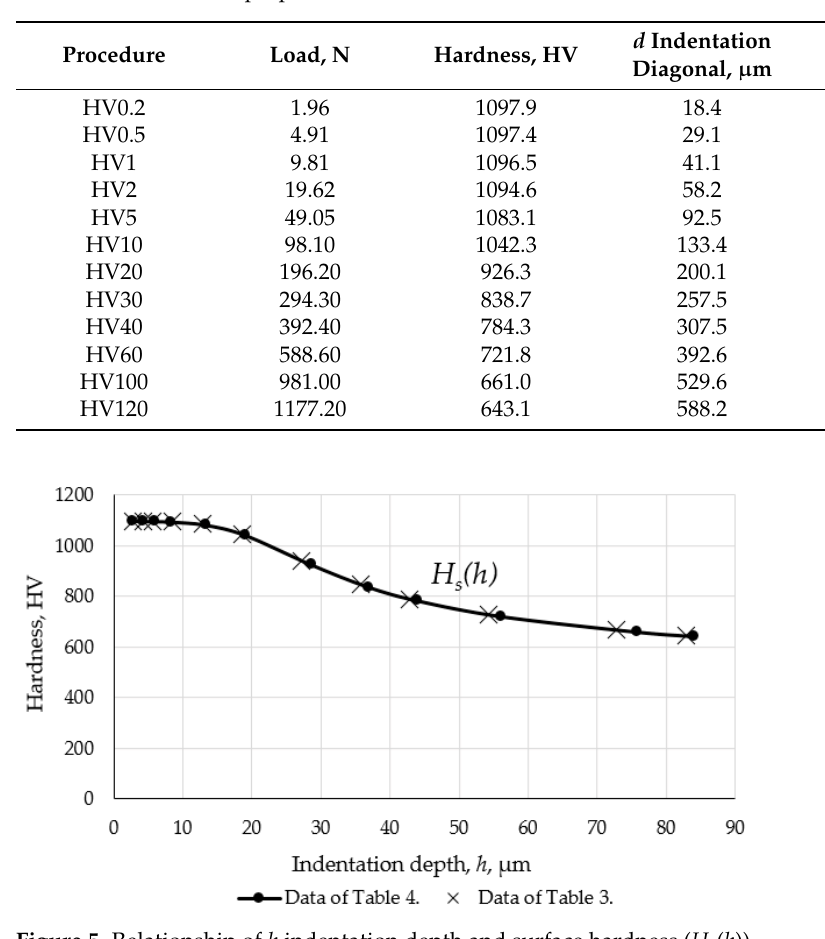
Table 4. Hardness and properties of indentation in the case of common loads.